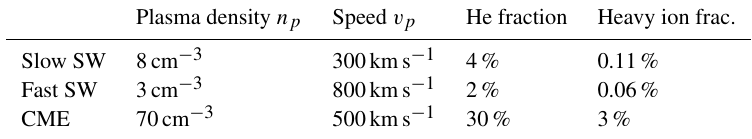
Table 1. Solar wind properties as used within this study. Helium and heavy ion fractions of the solar wind are used from Killen et al. (2012).